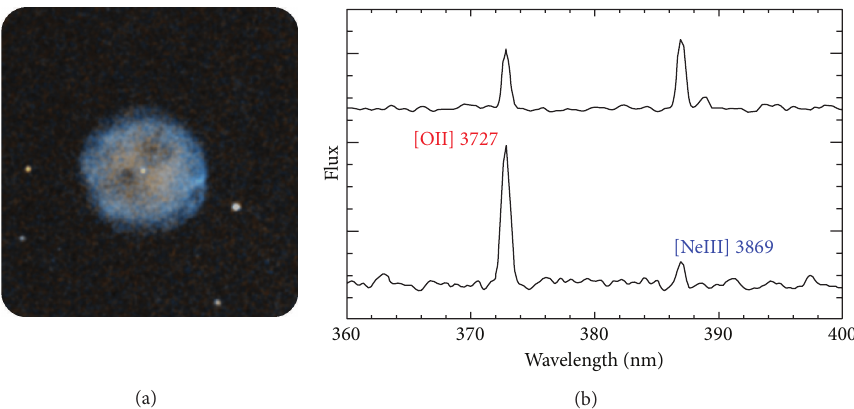
Figure 3: (a) Color-coded ([OII] 3727 in red, [NeIII] in blue) image of the planetary nebula M97, extracted from an SpIOMM data cube. (b) Spectra of selected pixels (binned 3 × 3 ) in the same cube with different [OII]/[NeIII] ratios.